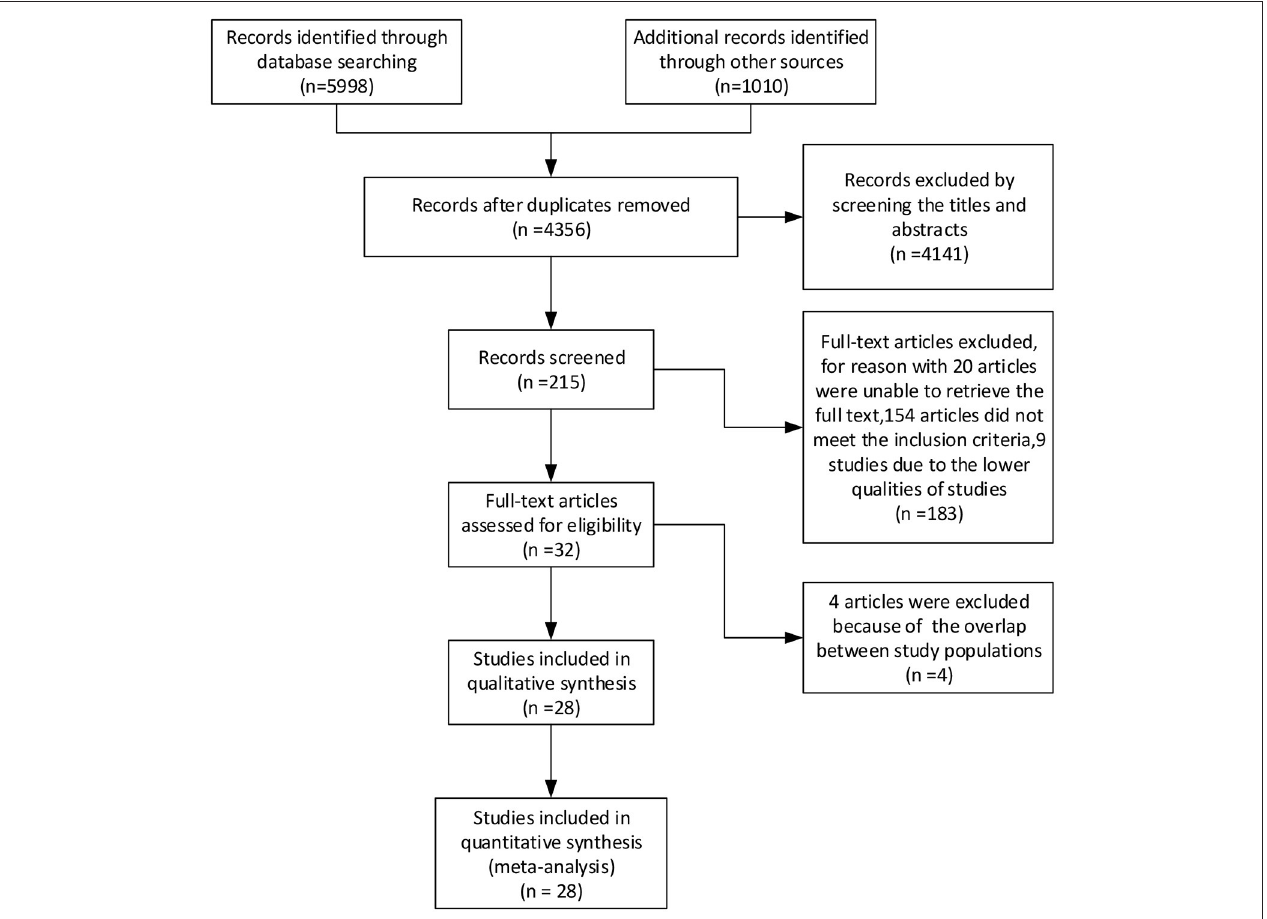
FIGURE 1 | A PRISMA flow diagram for the derivation of studies included in the